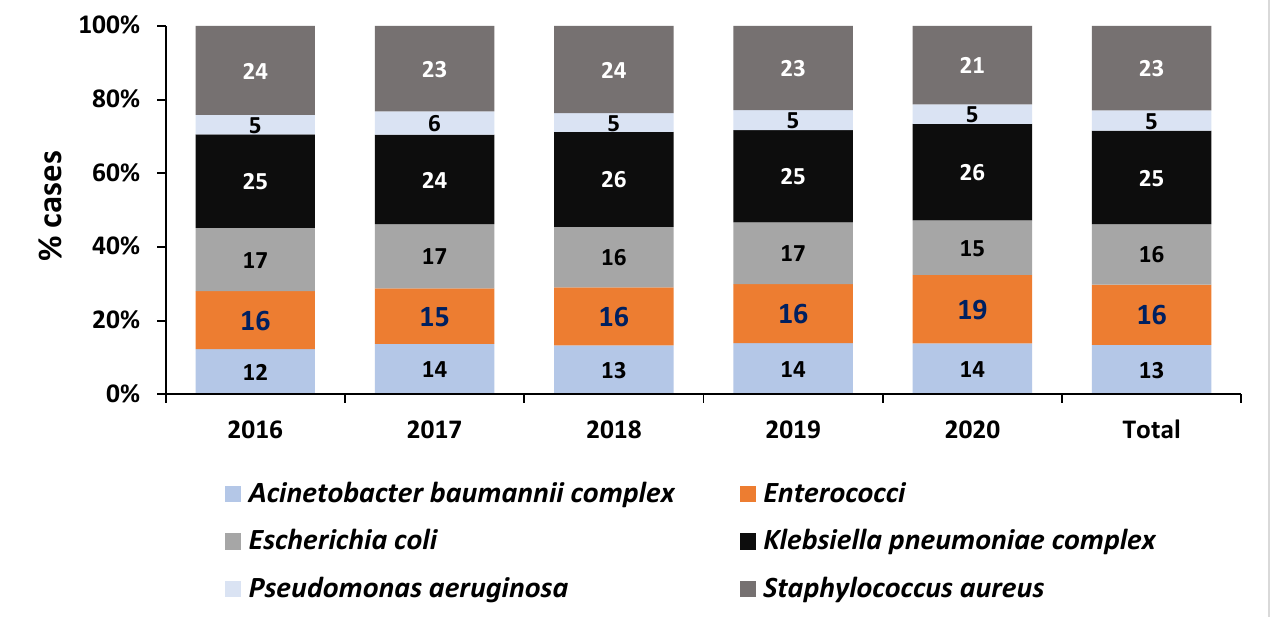
Figure 2. Distribution of cases with ESKAPE pathogens isolated from blood cultures in South Africa from 2016 to 2020 ( n = 130,352). Enterococci identified included: E. avium , E. casselifalvus , E. cecorum , E. columbae , E. durans , E. faecalis , E. faecium , E. gallinarum , E. hirae , E. raffinosus , and other E. species . Total = represents all ESKAPE pathogens from 2016–2020.